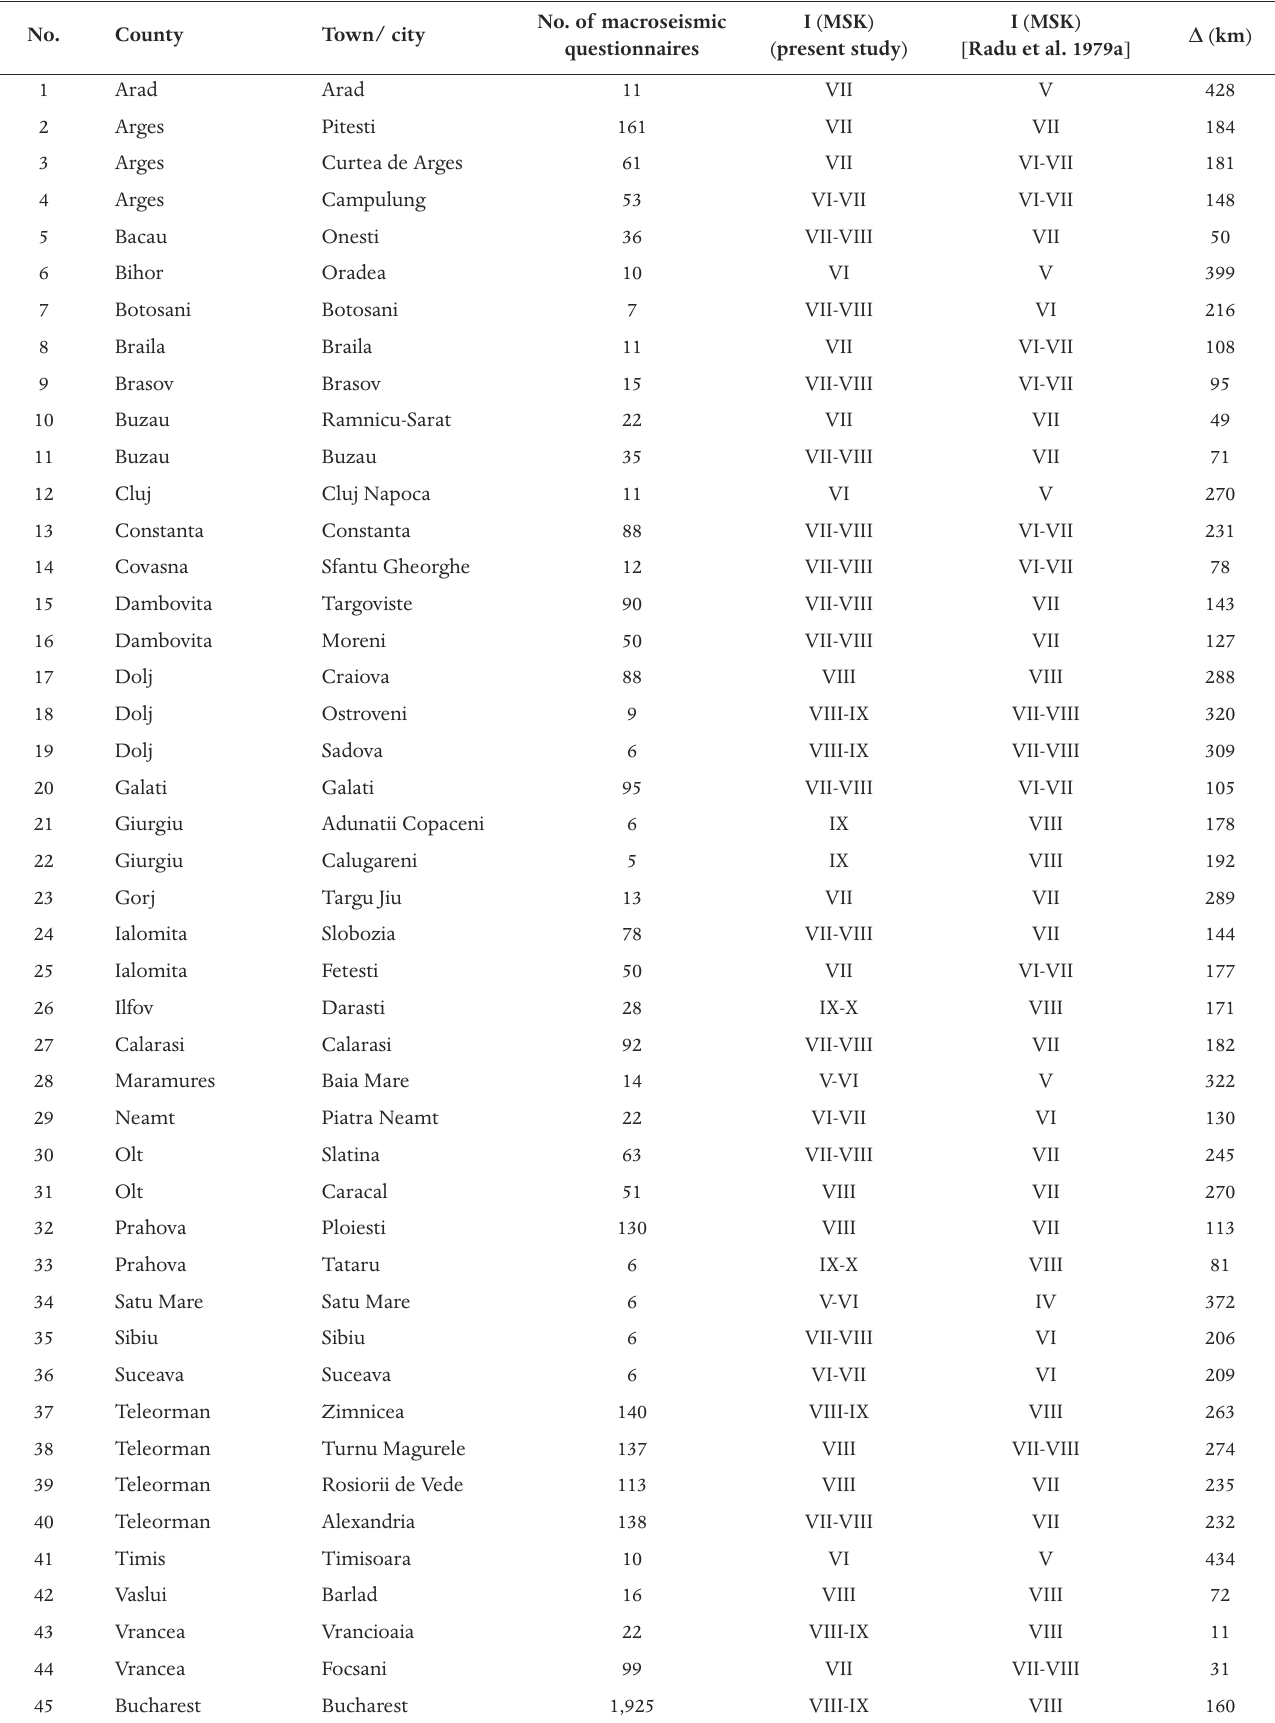
Table 1. Seismic intensities arising from the March 4, 1977, earthquake, for the important cities in Romania, and for some sites that suffered the greater damage. D (km), distance from